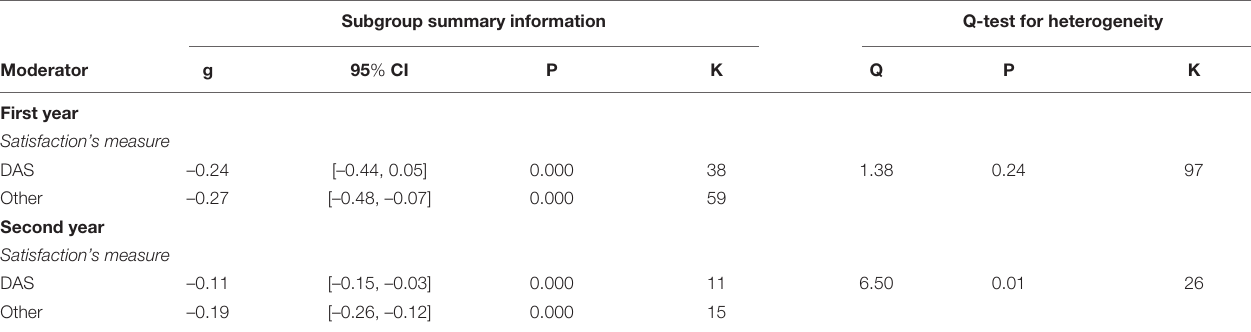
TABLE 2 | Sub-group analyses to test for moderation in the decrease in marital satisfaction (categorical moderators). Subgroup summary